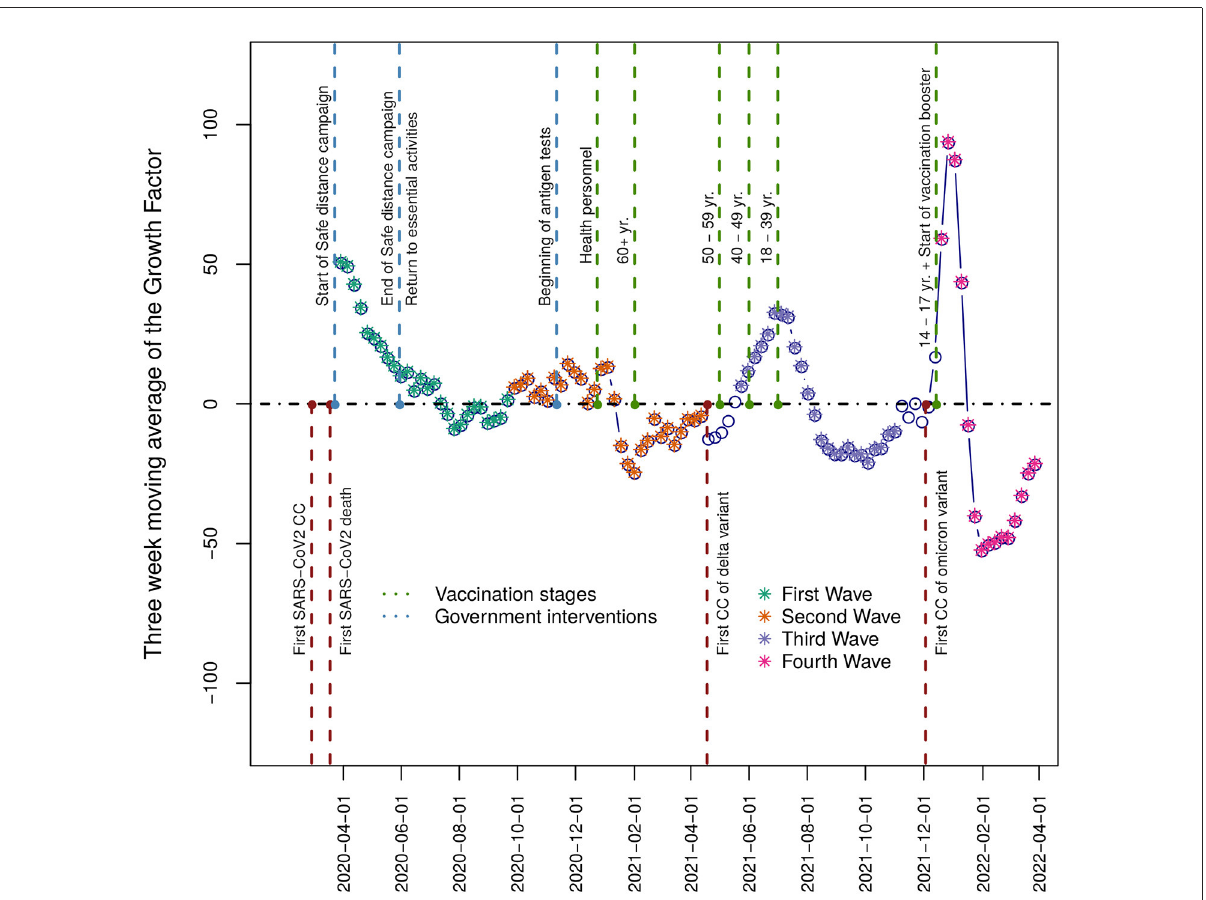
FIGURE4 Growth Factor. The plot displays in the vertical axis the three-week moving average of the growth factor time series for the period under study—relevant events such as the progress in vaccination official strategy, variant detection, and public policy health interventions are shown. The filled points represent each wave, and the empty points represent the interwave